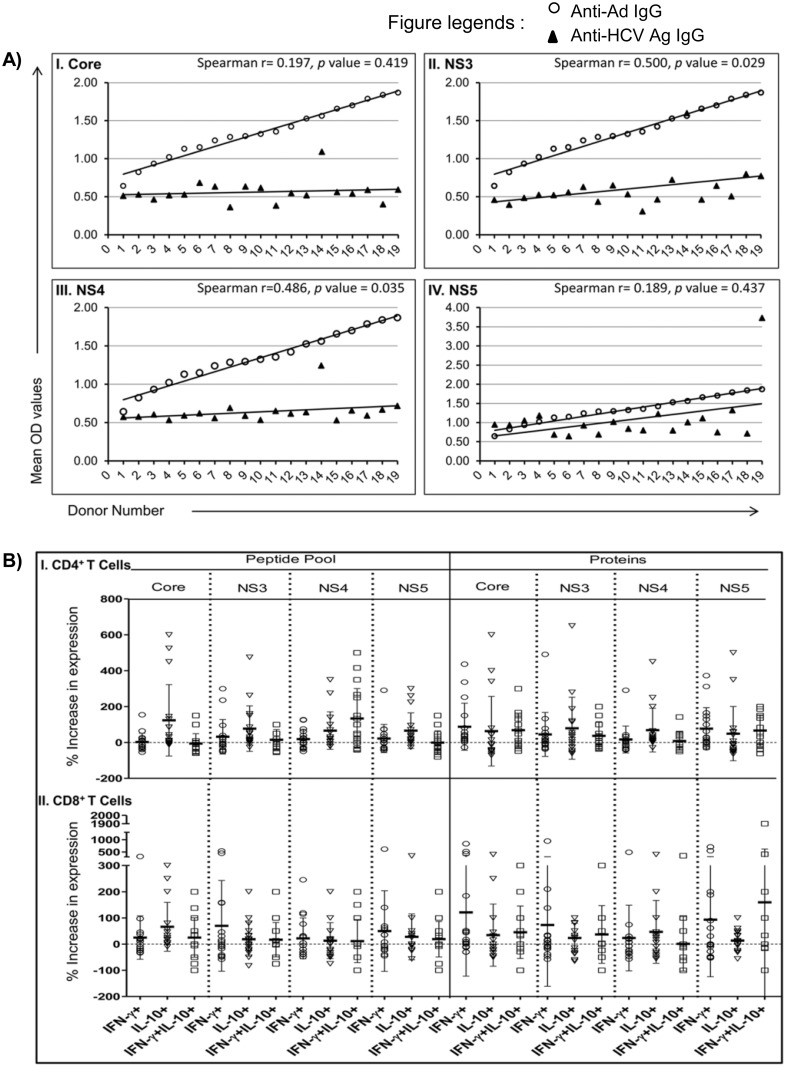
Healthy humans with pre-existing Ad immunity show HCV-specific cross-reactive immune responses.(A) Correlation of anti-Ad IgG with cross-reactive IgG against different HCV antigens. OD values for Ad-specific IgG (open circles) from 19 healthy donors were arranged in ascending order and matched with corresponding OD values for IgG against HCV core, NS3, NS4 or NS5 antigens (solid triangles). The Spearman coefficients were calculated for the data points that did not show normal distributions. (B) Expression of IFN-γ and IL-10 in CD4+ and CD8+ T cells upon ex vivo stimulation with HCV peptide pools or protein antigens. Data are shown as the percent increase in expression of IFN-γ, IL-10 and IFN-γ/IL-10 in an HCV antigens-dependent manner compared to controls (media). Data for each donor and data points from all donors (n = 17, two donors in the cohort did not provide enough blood samples to do cellular assays) are plotted in stacked dot plots as mean±SD.